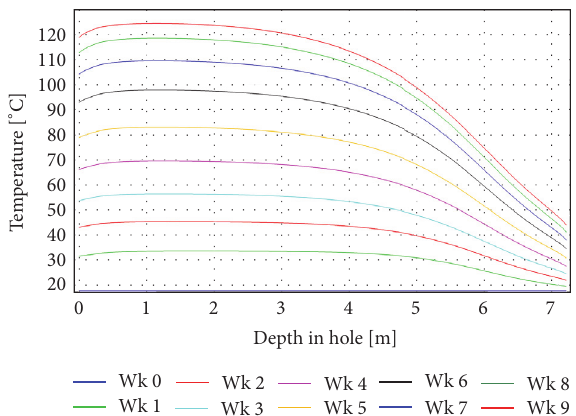
Figure 9: Calculated temperature at the center of the concrete liner (weeks 0–9).